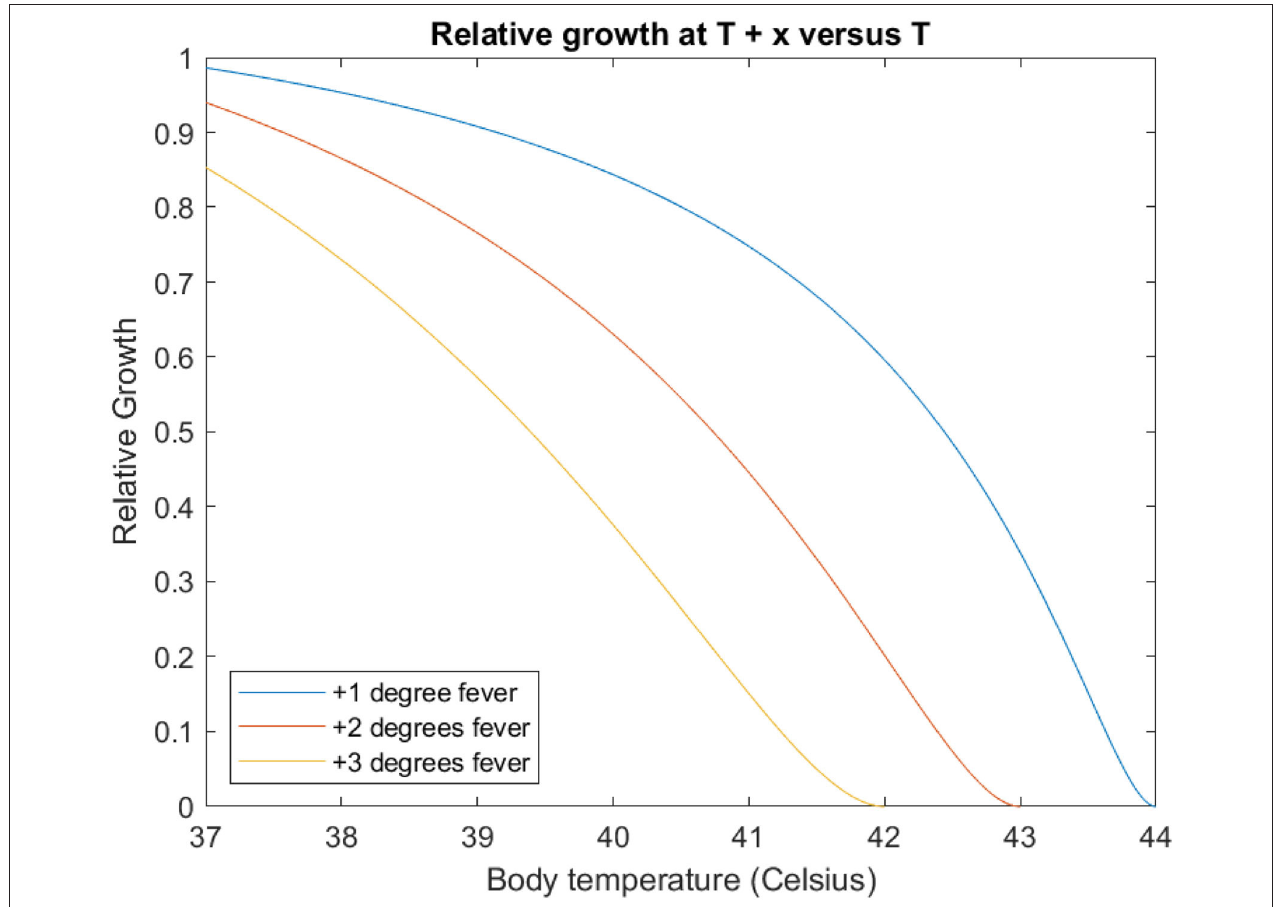
FIGURE 3 | Each curve gives the relative ratio of growth rate at T+x ◦ C (blue 1 ◦ C, red 2 ◦ C, yellow 3 ◦ C vs. a body temperature of T, modelled with the E. coli temperature-dependent growth curve. For example, the leftmost point of each curve corresponds to the impact of raising temperatures at 37 ◦ C of 0.99, 0.94, and 0.85, respectively, (cf. Table 1 ). Note each curve reaches zero when T